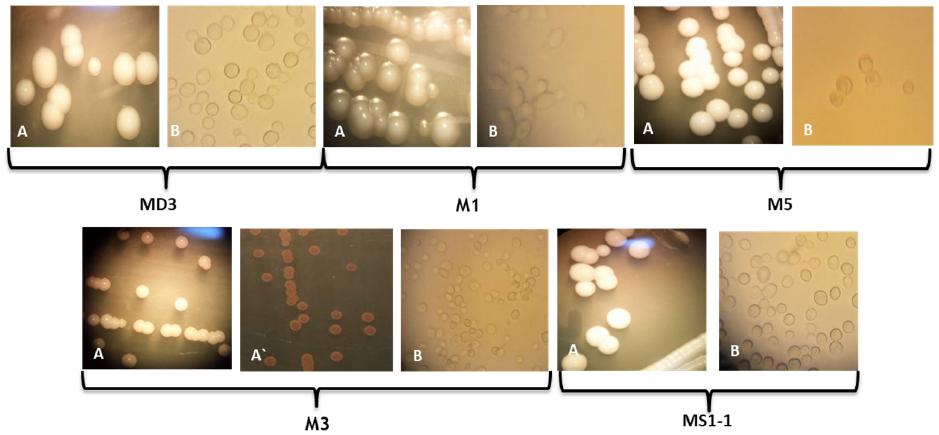
Figure 1. Appearance of colonies (A-averse; A‘ reverse) and cells (40 × ) (B) formed by yeasts isolated from wine wort (at 48 h; 28 °C; YPGA medium).